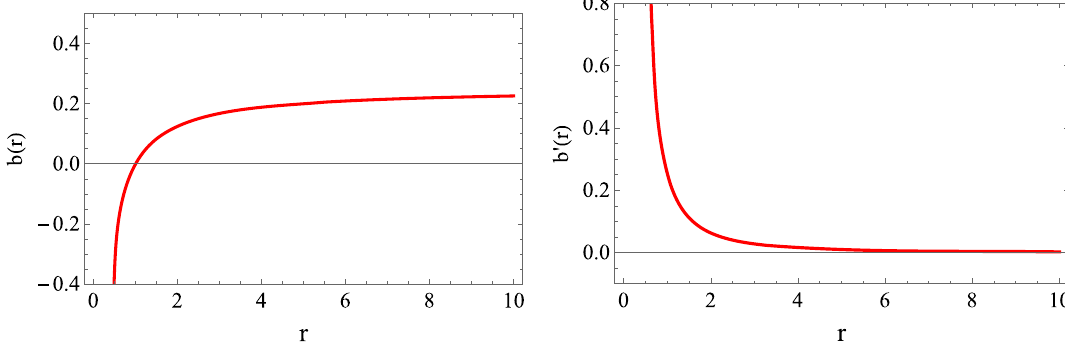
(cid:9) (cid:10) β r 0 . The constants are α = 0 . 1, ρ 0 = 0 . 01 and r 0 = 1 along r